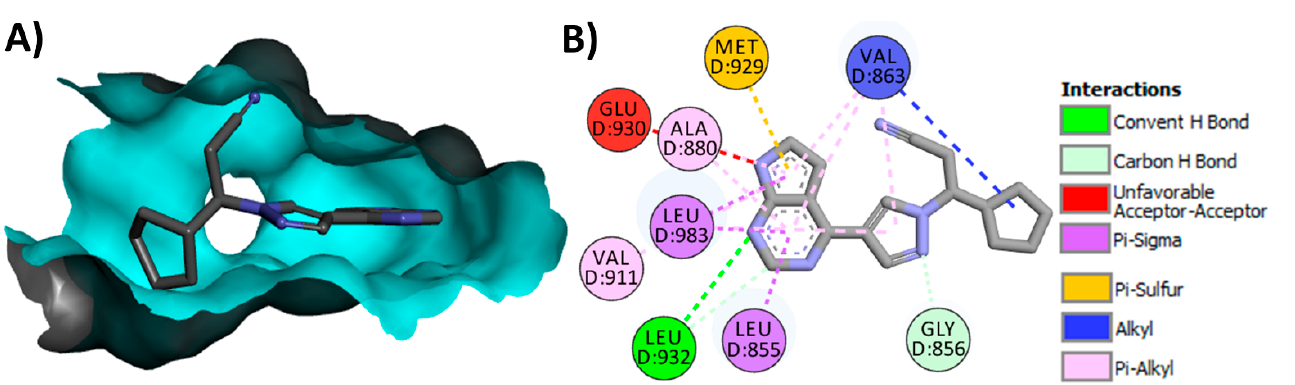
Figure 53. Binding modes of ruxolitinib (shown as sticks) into human JAK2 JH1 (pdb: 6WTN): ( A ) 3D binding mode, receptor shown as a hydrogen bond surface; ( B ) 2D binding mode showing dif- ferent types of interactions with JAK2 JH1; hydrogen atoms were omitted for clarity; this figure was generated using Discovery Studio Visualizer (V16.1.0.15350).